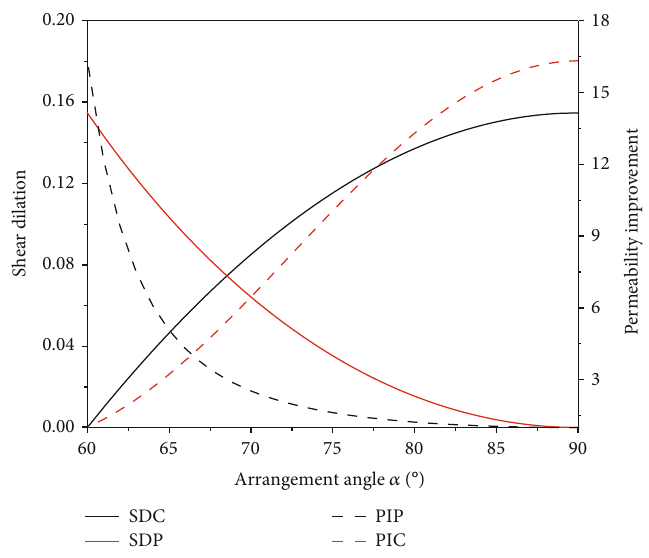
Figure 8: 2D evolutions of the shear dilation and permeability improvement